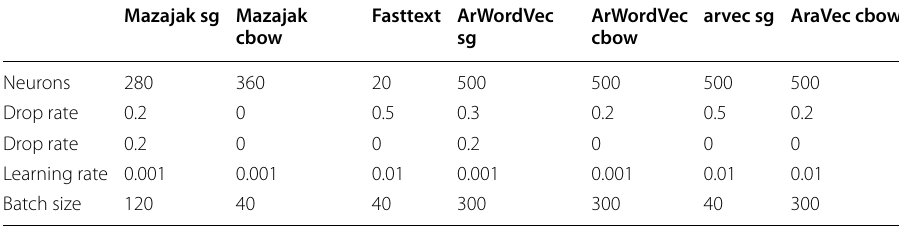
Table 14 Optimal hyperparameters of the